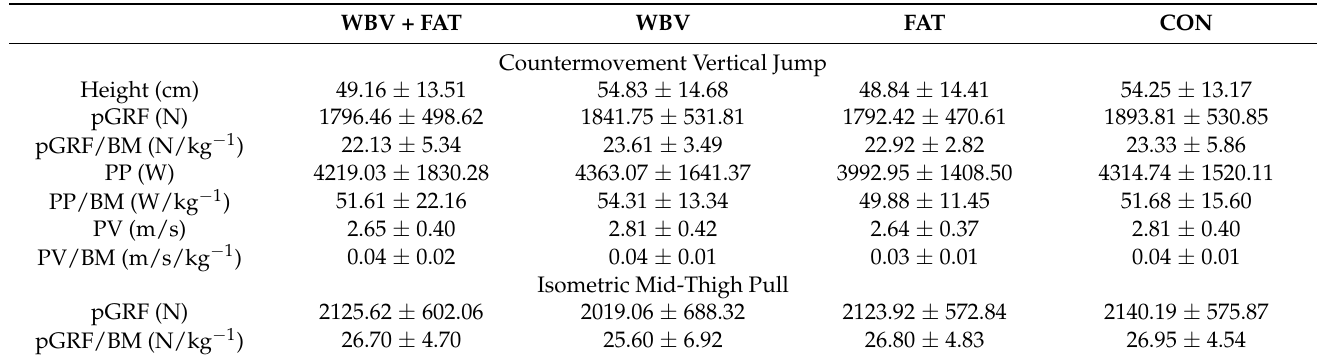
Table 1. Vertical jump and isometric mid-thigh pull mean and SD data (n =